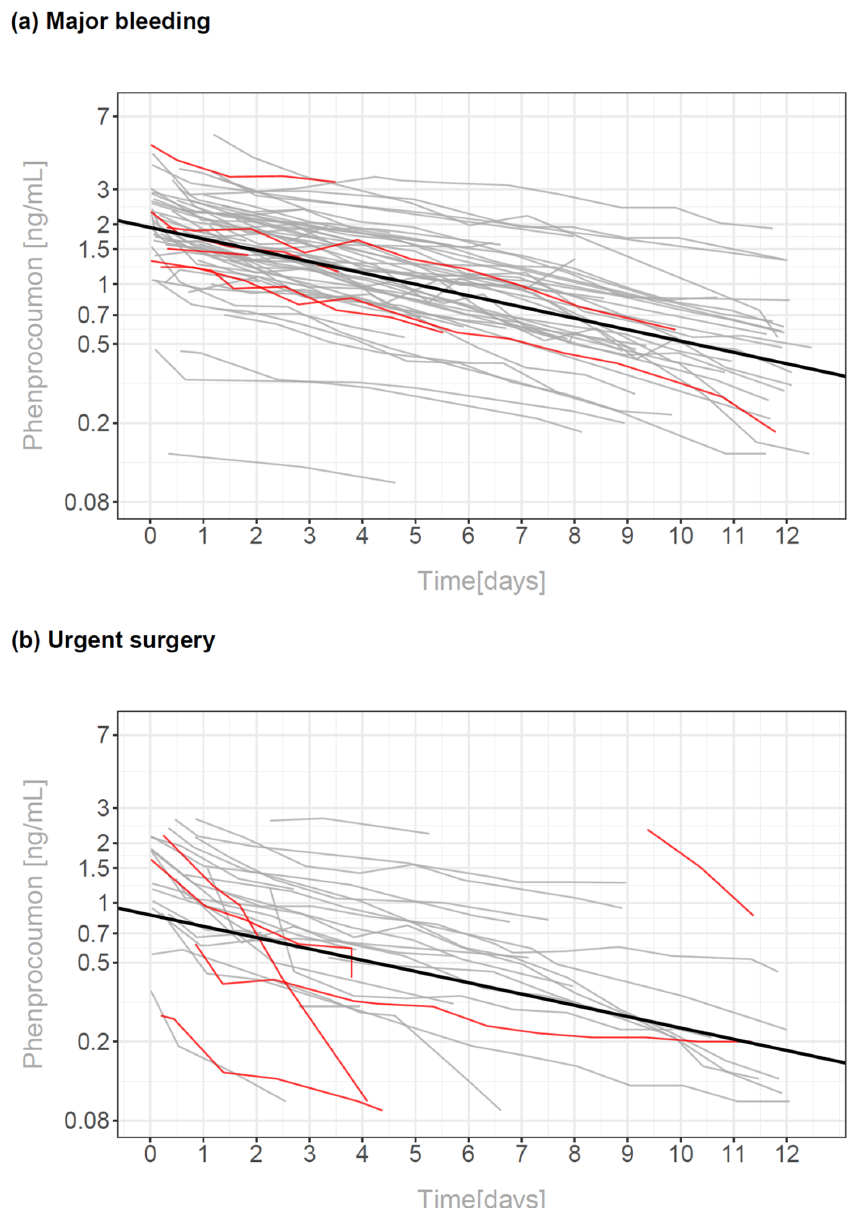
Figure 2. Course of phenprocoumon levels over time in patients with major bleedings ( a ) and in patients with urgent surgery ( b ). The regression lines were calculated by a single linear mixed model excluding data after early re-exposure to phenprocoumon and are shown as thick lines in each panel. Patients who died within 30 days after hospital admission are marked by red lines.